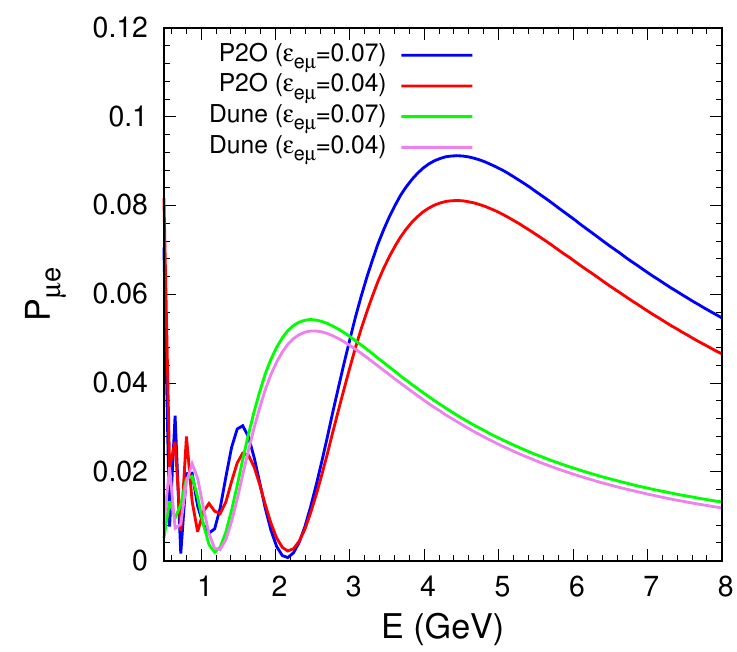
Figure 4 . Appearance channel probability for neutrinos considering two sets of parameters in P2O and DUNE baselines. The sets of parameters are: | (cid:15) eµ | = 0 . 04 , sin 2 θ 23 = 0 . 46 , φ eµ = 210 ◦ , δ CP = 60 ◦ and | (cid:15) eµ | = 0 . 07 , sin 2 θ 23 = 0 . 45 , φ eµ = 195 ◦ , δ CP = 75 ◦ . This panel is generated for true normal